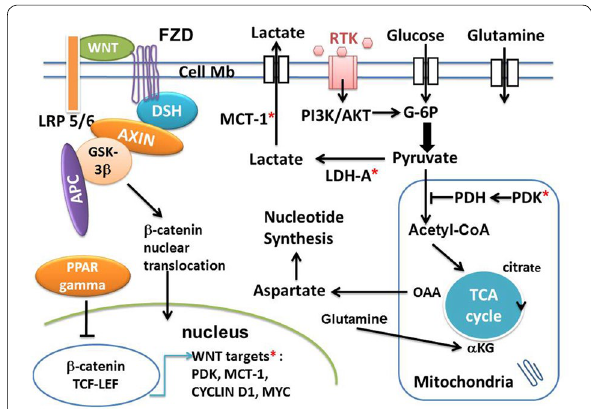
Fig. 1 Schema of interactions between the canonical WNT/ beta‑catenin pathway and PPAR gamma under aerobic glycolysis conditions in cancer. In the absence of the WNT ligands (“off state”), cytosolic beta‑catenin is phosphorylated by GSK‑3 beta. APS and AXIN combine with GSK‑3 beta and beta‑catenin to enhance the destruction process in the proteasome. In the presence of the WNT ligands (“on state”), Wnt binds both Frizzled and LRP5/6 receptors to initiate LRP phosphorylation and dishevelled‑mediated Frizzled internalization. This leads to dissociation of the AXIN/APC/GSK‑3 beta complex. Beta‑catenin phosphorylation is inhibited which prevents its degradation in the proteasome. Thus, beta‑catenin accumulates in the cytosol and then translocates to the nucleus to bind TCF‑LEF co‑ transcription factors. This induces the WNT‑response gene transcrip‑ tion (PDK, MCT‑1, MYC, CYCLIN D1). Glucose itself activates the WNT pathway. PPAR gamma inhibits the beta‑catenin/TCF‑LEF‑induced activation of WNT target genes. PDK inhibits the PDH complex in mitochondria. Thus pyruvate cannot be fully converted into acetyl‑ CoA and enter the TCA cycle. MYC activates LDH‑A which converts cytosolic pyruvate into lactate. MCT‑1 favors lactate extrusion out of the cytosol which favors angiogenesis. MYC increases glutamine entry in the cytosol and mitochondria. MYC‑induced glutamine enhances aspartate and nucleotide synthesis. APC adenomatous polyposis coli, alpha ‑ KG alpha ceto‑glutarate, DSH Dishevelled, FZD Frizzled, GSK ‑ 3beta glycogen synthase kinase‑3beta, LDH lactate dehydrogenase, LRP5/6 low‑density lipoprotein receptor‑related protein 5/6, MCT ‑ 1 monocarboxylate lactate transporter‑1, OAA: oxalo‑acetic acid, PPAR gamm peroxisome proliferator‑activated receptor gamma, PDH pyruvate dehydrogenase complex, PDK pyruvate dehydrogenase kinase, RTK receptor tyrosine kinase, TCF/LEF T‑cell factor/lymphoid enhancer factor, TCA tricarboxylic acid, *WNT targets: PDK, MCT‑1, MYC, CYCLIN